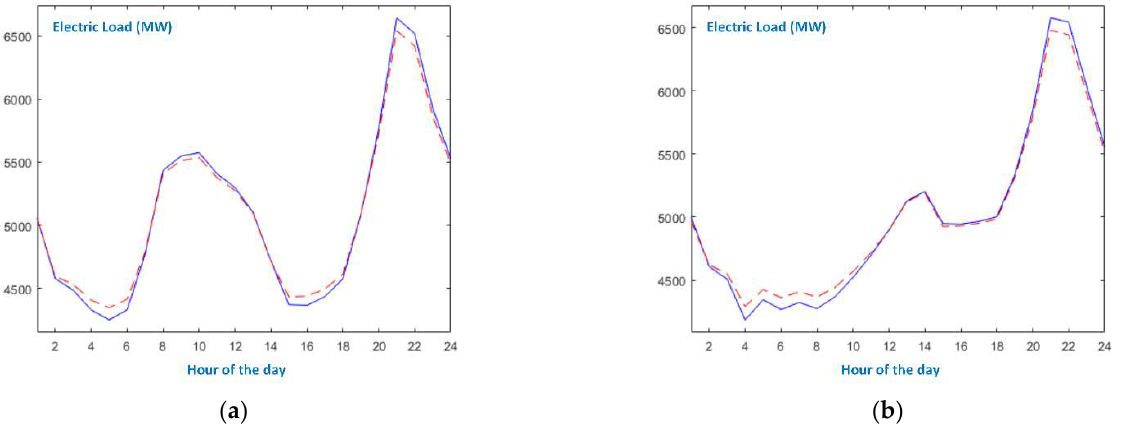
Figure 6. Presentation of spring days. The blue solid line is the actual electric load, and the red